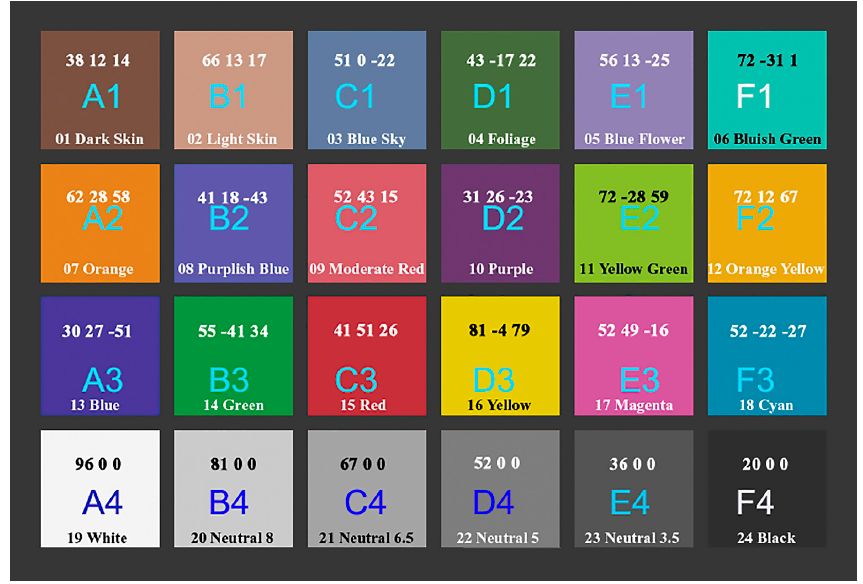
Figure 2. X-Rite Color Checker (CC) Classic array, with CIELab values.